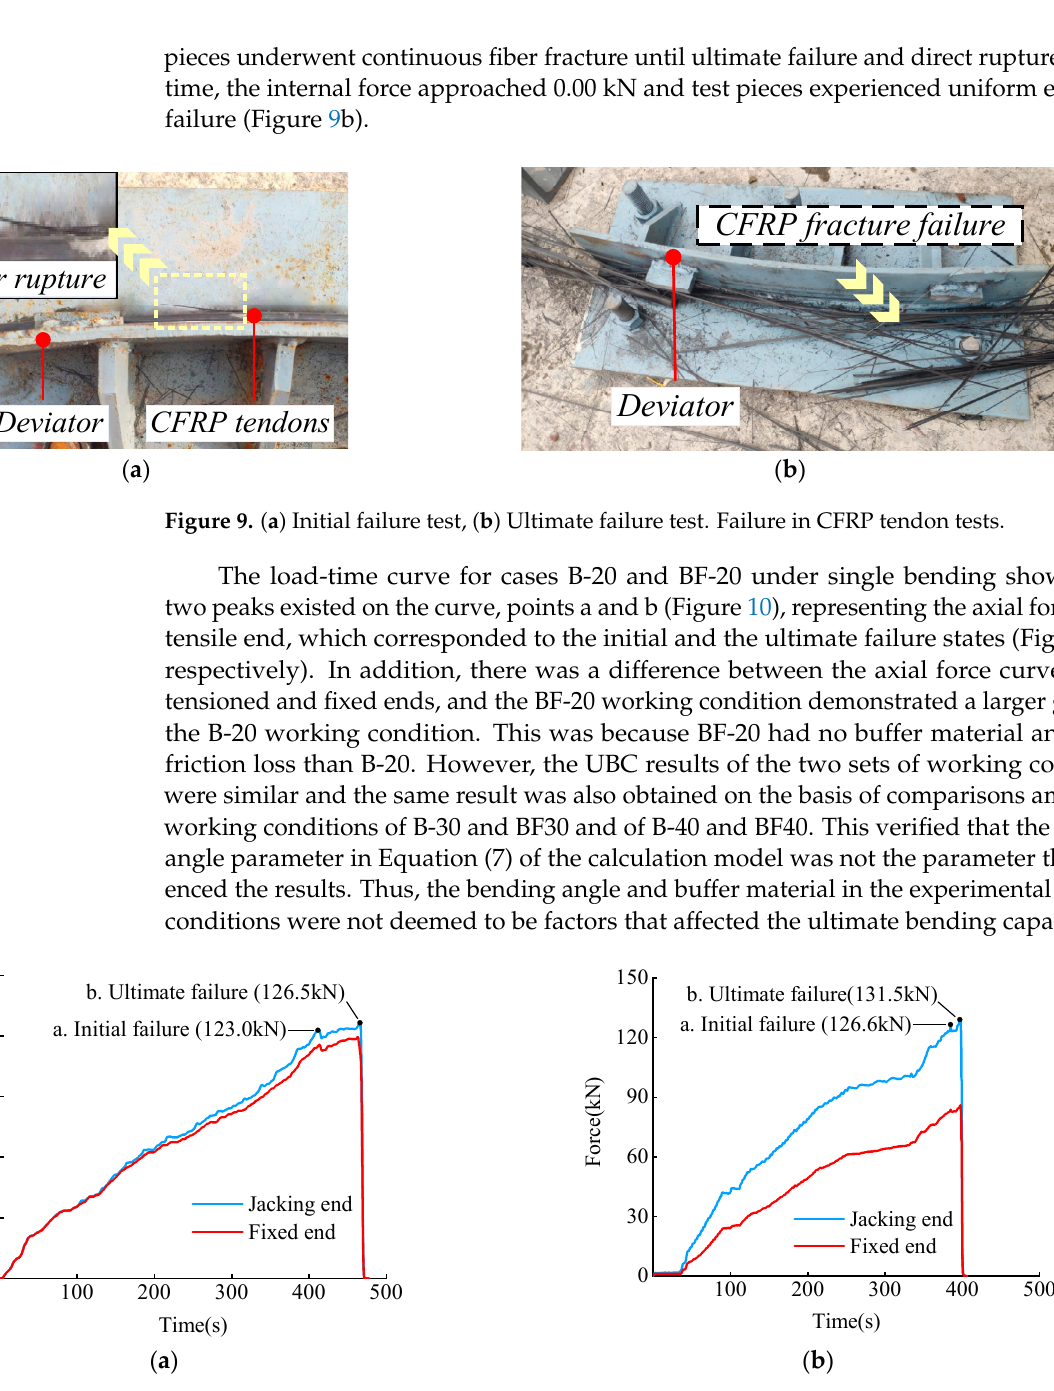
Figure 10. ( a ) Load-time curve for working condition B-20, ( b ) Load-time curve for working condition BF-20. Load-time curve of CFEP tendon tests.